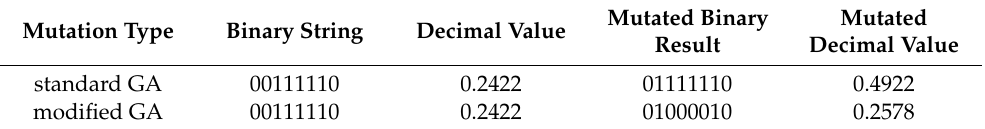
Table 4. Comparison between two mutation operators with an assumed variable range from 0 to 1.